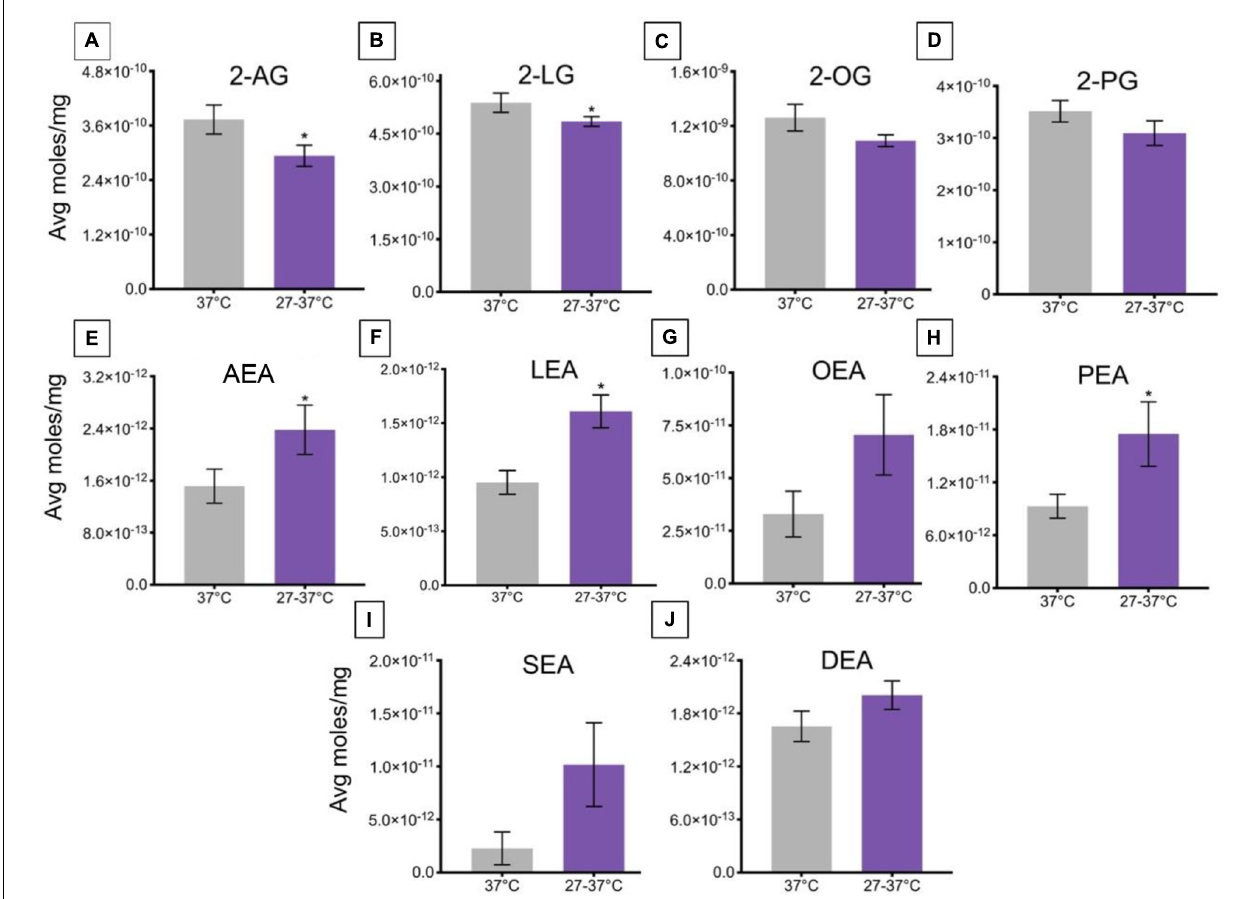
FIGURE 4 | Changes in lipid levels of 2-acyl glycerols (A–D) and N -acyl ethanolamines (E–J) upon an increase in temperature from 27 to 37 ◦ C. Significant temperature-induced changes after TRPV1-HEK293 cells were exposed to a change in ambient temperature from 27 to 37 ◦ C is indicated by * ( p ≤ 0.05). Data depicted in each graph were averaged over 15 total data points per condition ( n = 3 individual experiments) and are presented as average moles/mg ( y -axis).